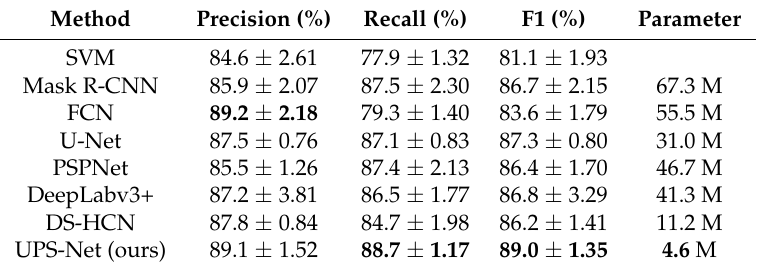
Table 3. Comparison of raft aquaculture areas extraction between SVM, Mask R-CNN, FCN, U-Net, PSPNet, DeepLabv3+, Encoder-Decoder and UPS-Net (average of 5 runs with the standard deviation). The values in bold format are the highest